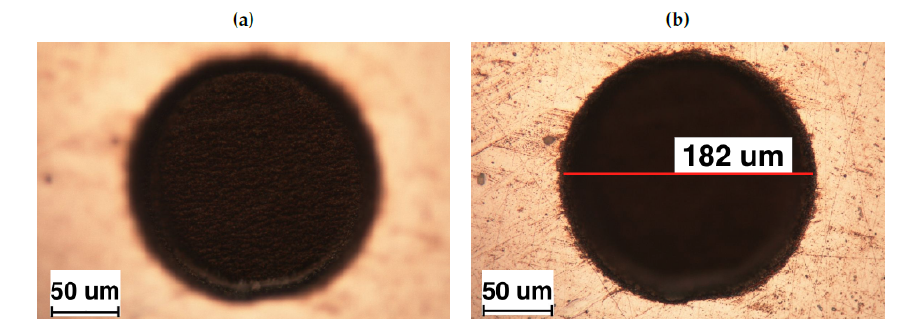
Figure 4. Optical microscope image of ( a ) the bottom and ( b ) the top of a representative dimple.